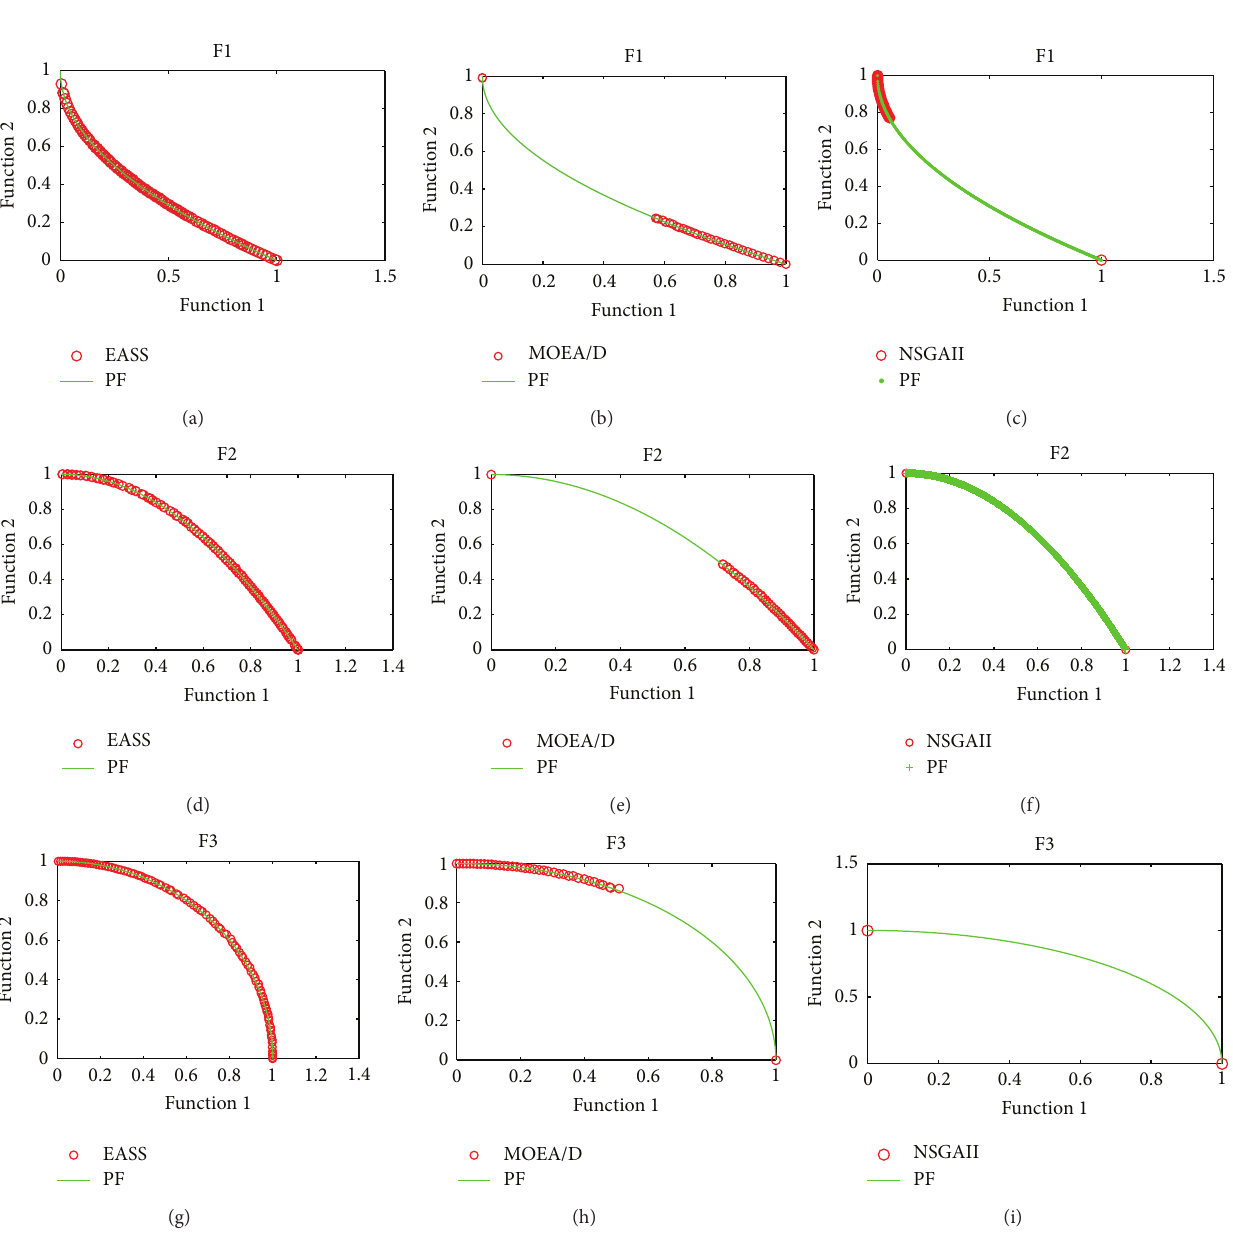
Figure 1: Solutions obtained by EASS, MOEA/D, and NSGAII on